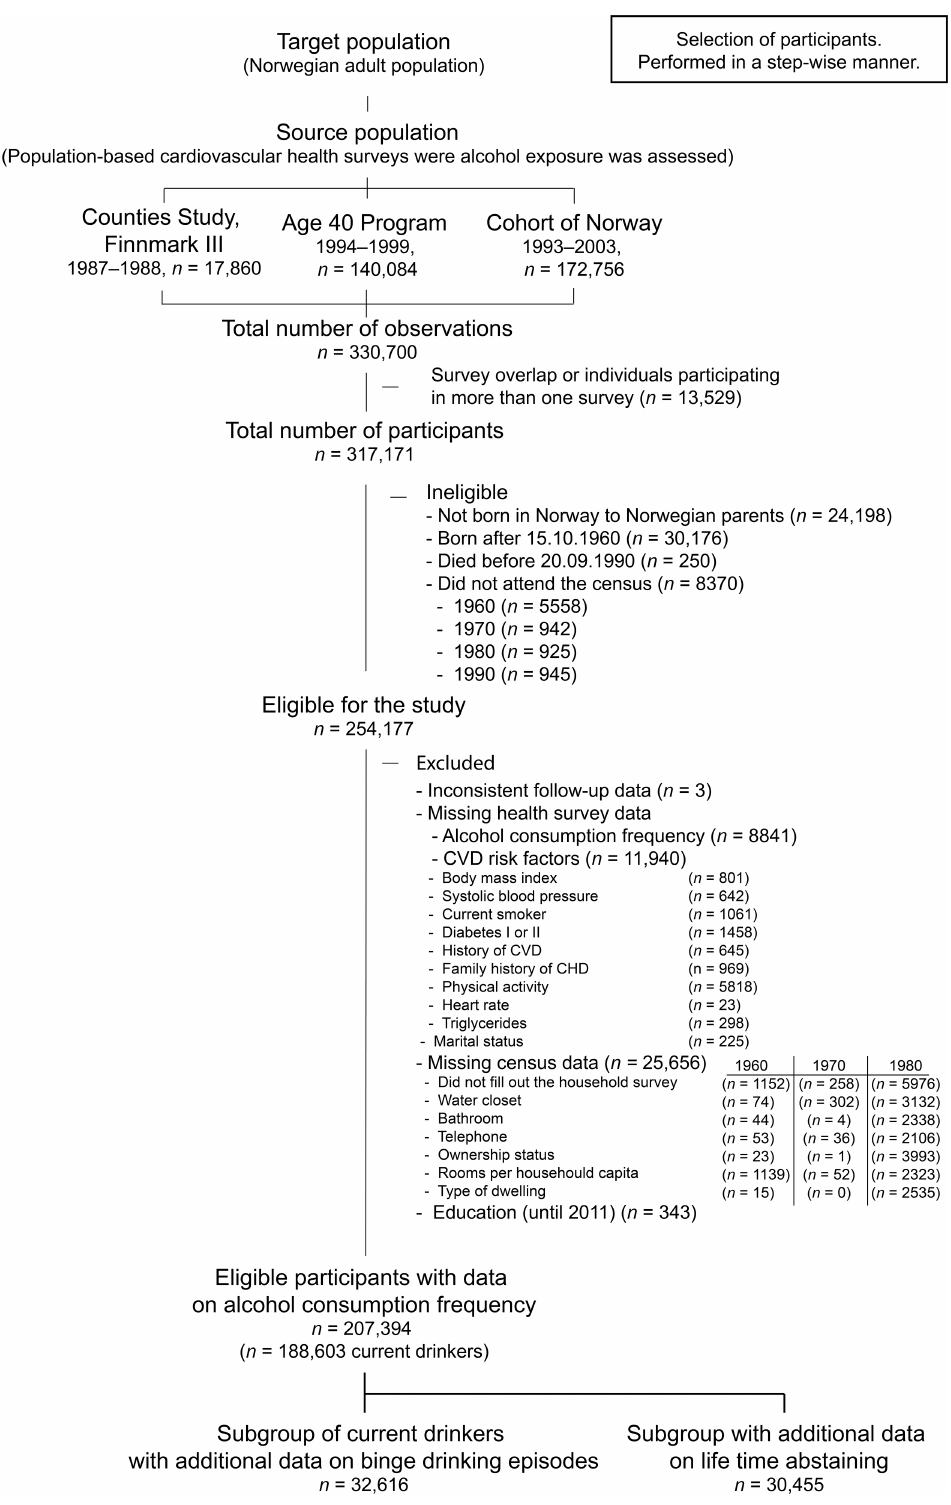
Fig 1. Flow chart showing inclusion and exclusion. CHD, coronaryheart disease;CVD, cardiovascular disease.